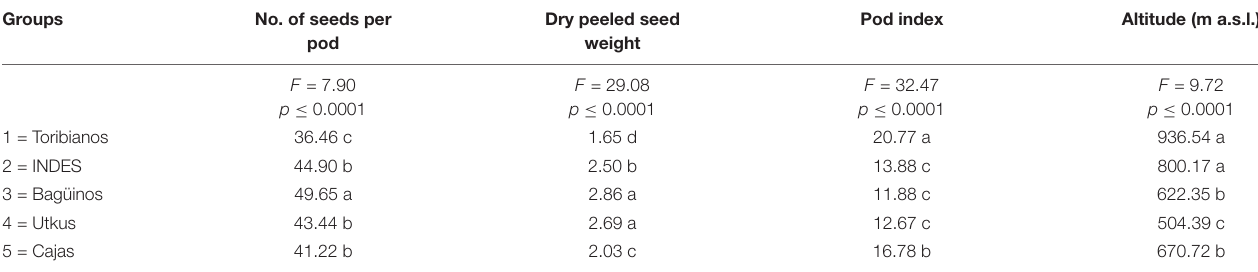
TABLE 1 | Characteristics of the genetic groups based on the quantitative variables of productivity and altitude characteristics of the sample collection. Groups No. of seeds per Dry peeled seed Pod index Altitude (m pod weight